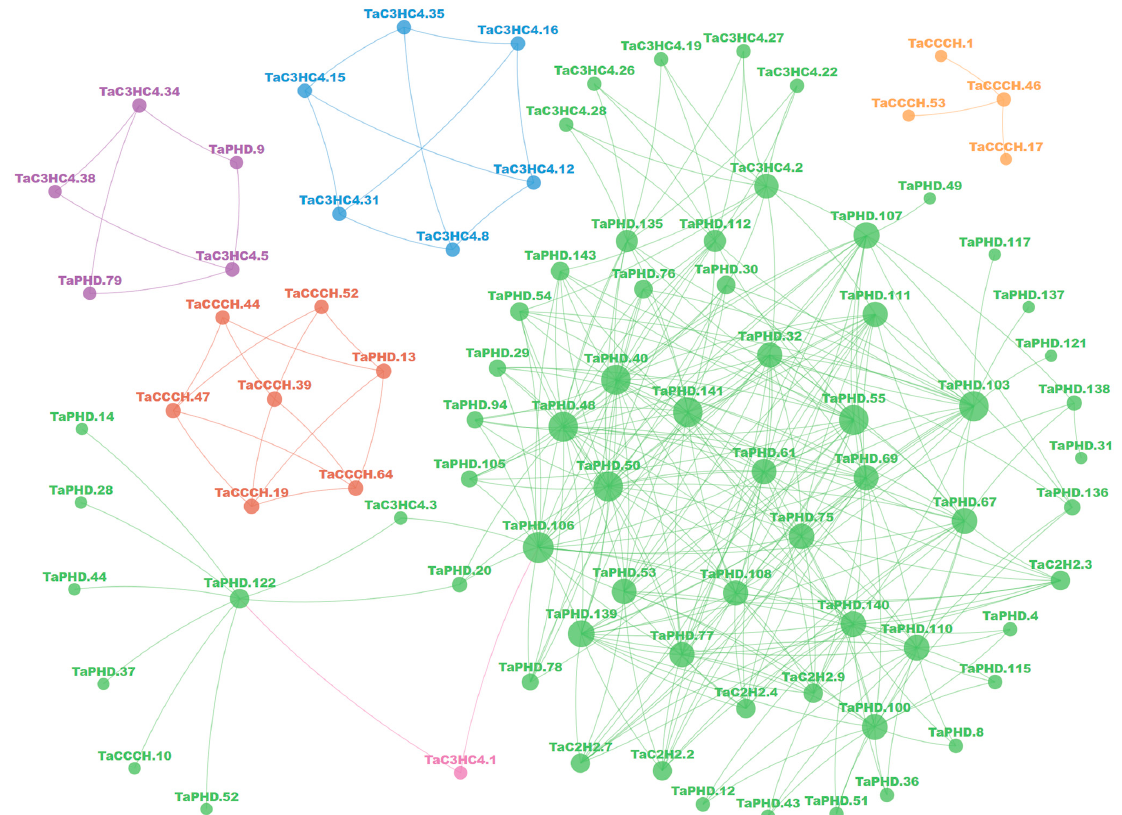
Figure 6. Putative interaction network of TaZFPs in T. aestivum . A total of 366 interactions are shown between 88 TaZFPs. The size of the circle is a mapping of the number of interacting objects. The colour of the circle represents the clustering category to which it belongs.